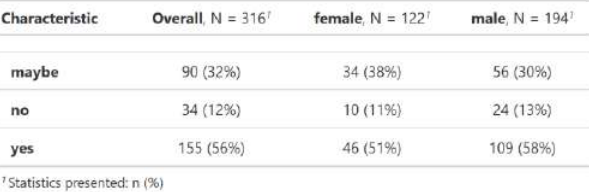
Table 23: Do you know if India gives any scholarships to Afghan students?